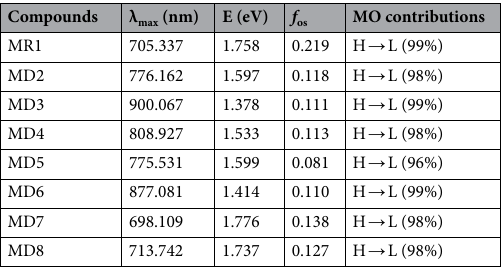
Table 3. Computed energy, wavelength (λ max ) and oscillator strength for MR1 and MD2–MD8 in gaseous phase. HOMO = H, LUMO = L, f = oscillator strength, MO = molecular orbital.